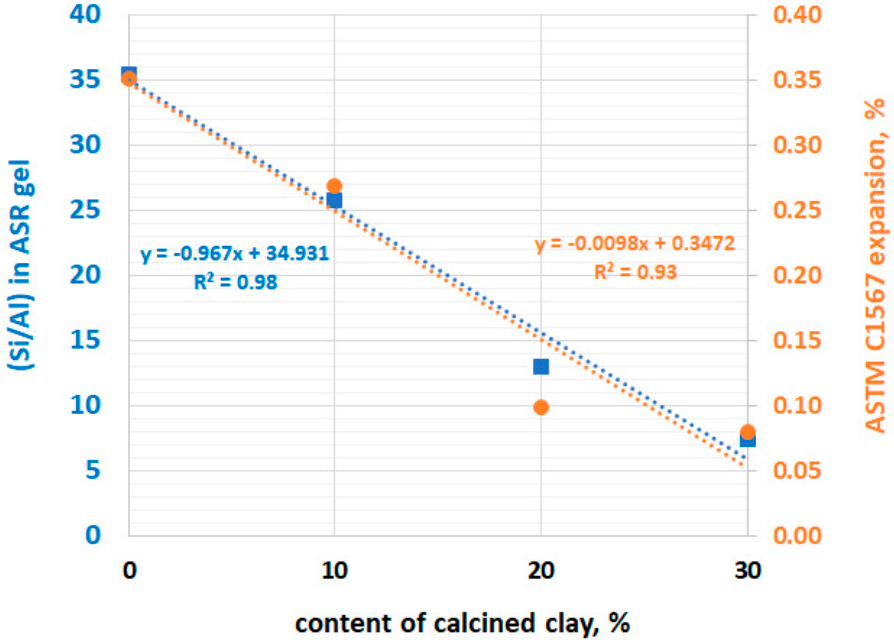
Figure 5. The relationship between the ASTM C1567 expansion and the Si/Al ratio in the ASR gel in relation to the content of the calcined clay cement substitute.